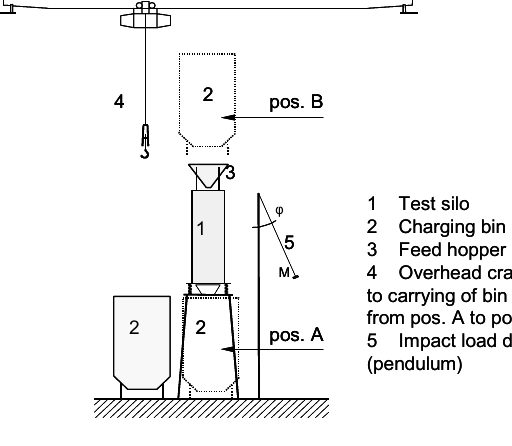
Fig. 2. Test stand.